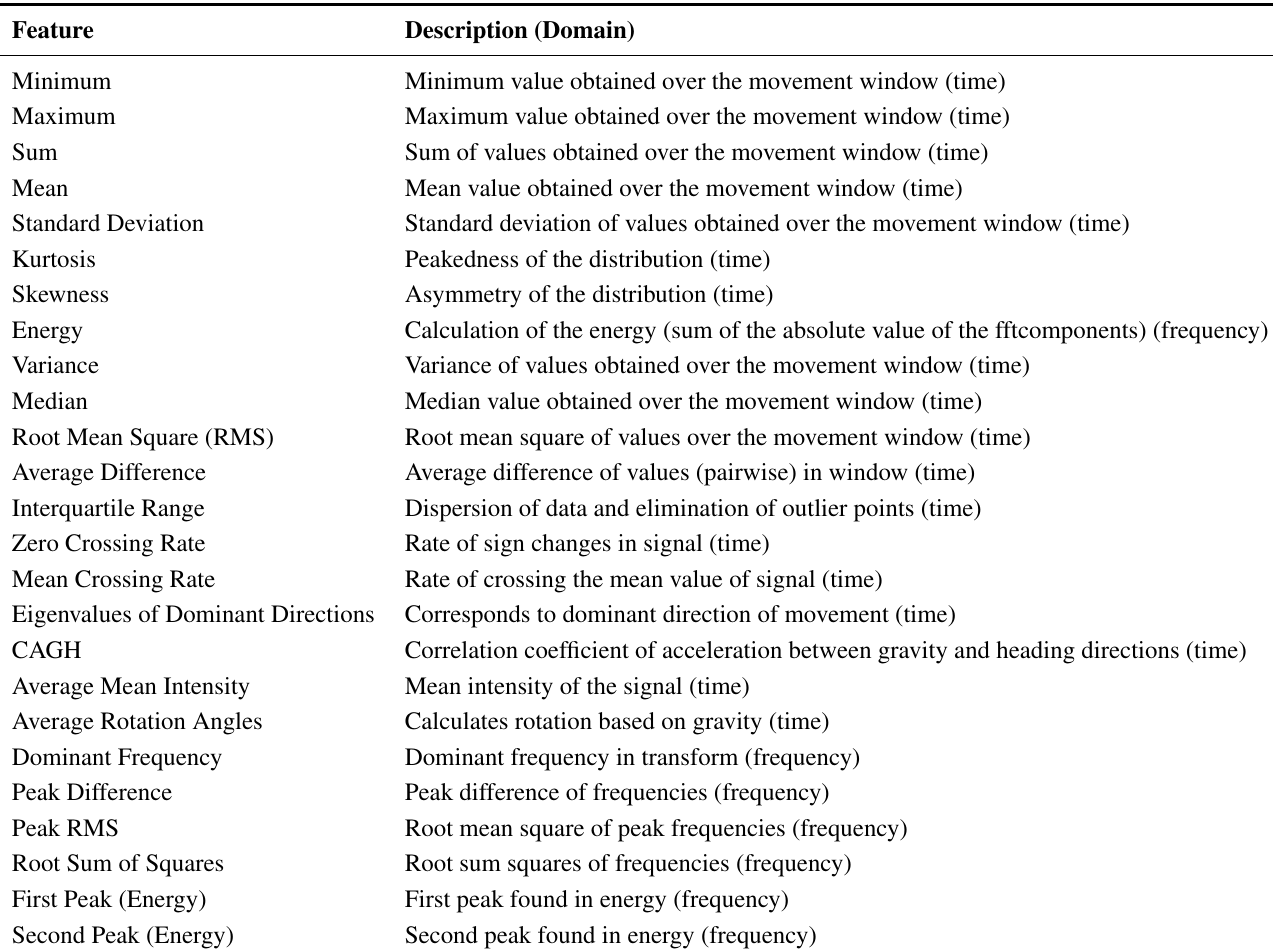
Table 2. Features extracted per